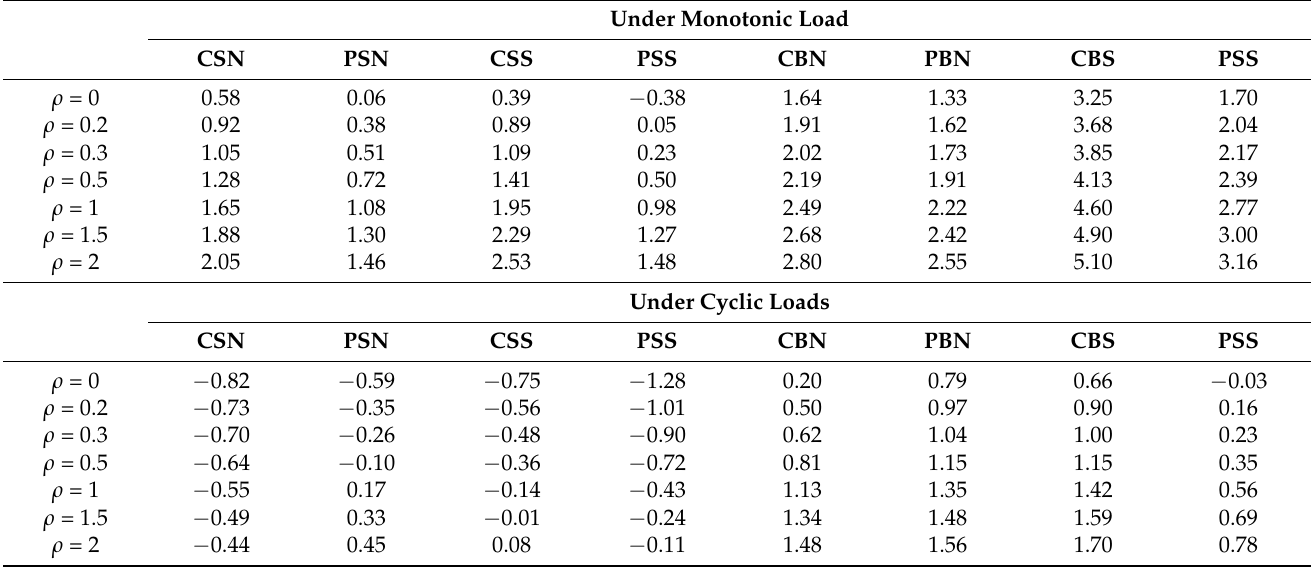
Table 6. Reliability index of the design values calculated by Eurocode